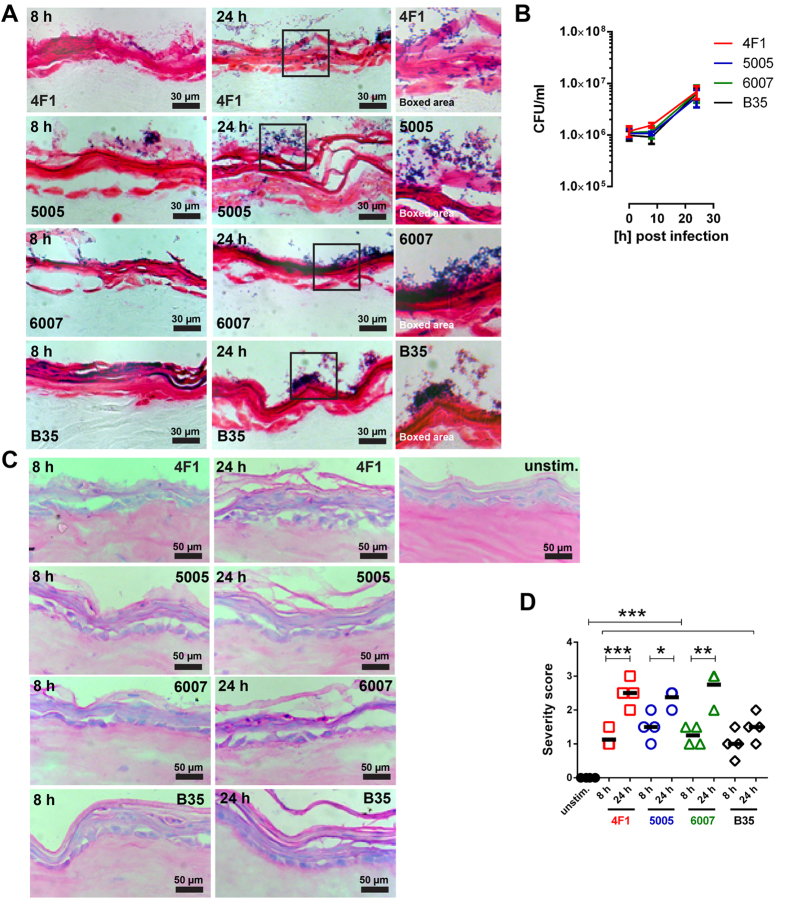
SDSE infections in skin tissue model.(A) Representative micrographs of Gram-stained infected tissue with indicated SDSE strains and total CFU counts (B) of bacteria recovered from skin tissue models. The data represent the mean values ± SD (n = 3). (C) Histological analysis of the skin model tissue after infection. Representative images with indicated time points post infection with indicated strains are shown. (D) Blinded scoring of tissue pathology of the skin model after infection. Horizontal lines denote median values. The statistical significance was determined using Kruskal-Wallis with Dunn´s multiple comparison test. (*p < 0.05; **p < 0.01; ***p < 0.001).